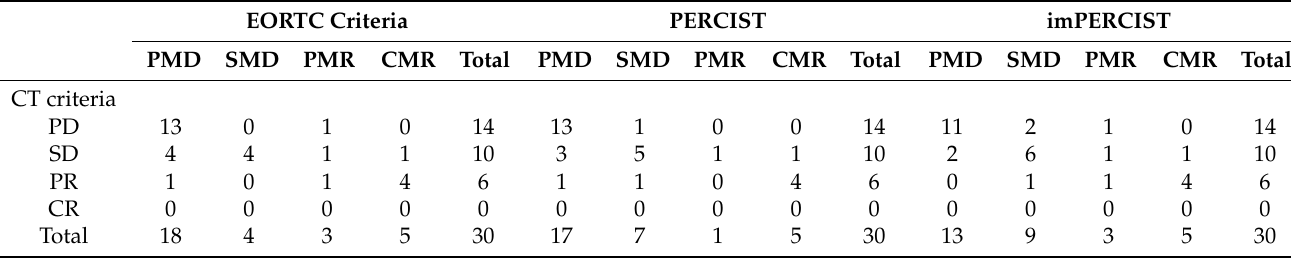
Table 4. Comparison of treatment response assessments in CT criteria (combined modified RECIST and RECIST1.1) and three PET criteria (EORTC criteria, PERCIST,